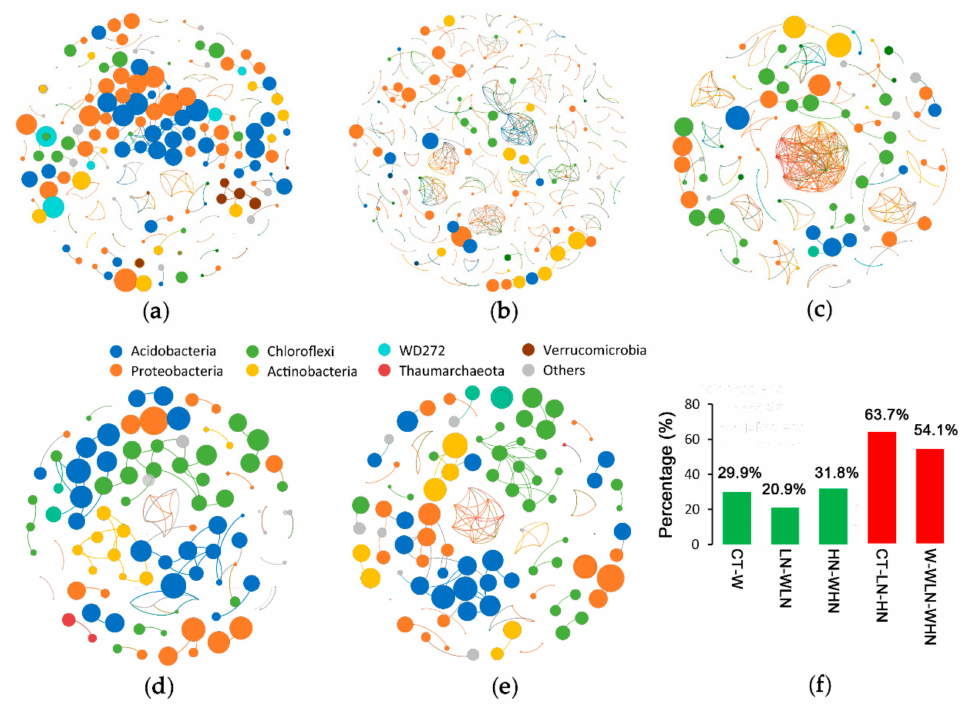
Figure 3. Co-occurrence of ecological networks between the samples. Co-occurrence